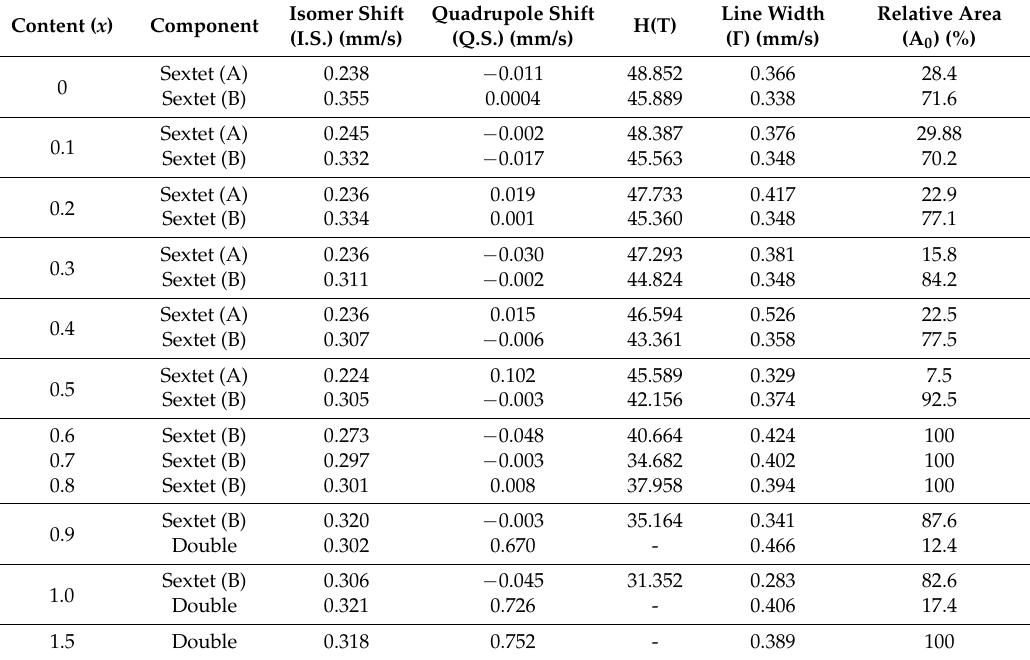
Table 3. Mössbauer parameters of CoAl x Fe 2- x O 4 samples, which were calcined at 1000 °C.